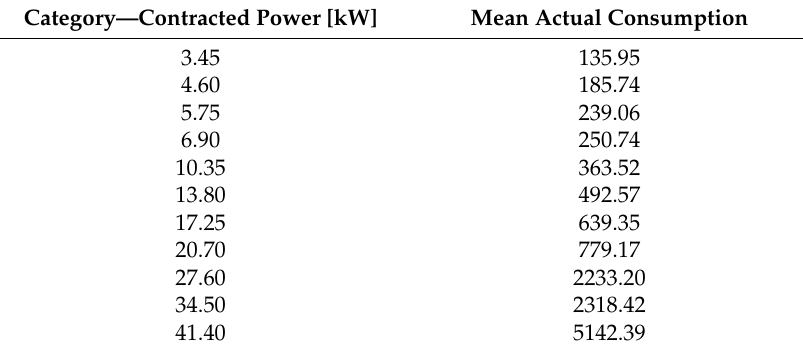
Table 3. Categories of contracted power and mean actual consumption.